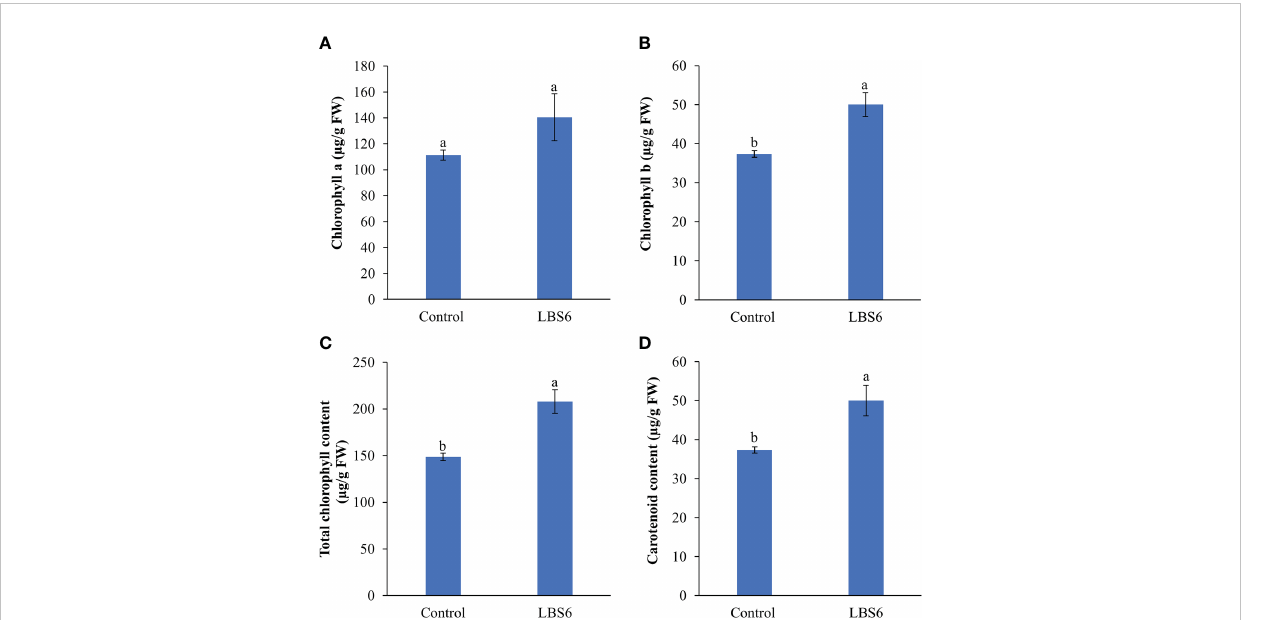
FIGURE 2 LBS6 improved the pigment content of treated cotyledons. (A) chlorophyll a, (B) chlorophyll b, (C) total chlorophyll, and (D) carotenoid content of seven-day old cotyledons treated with water (Control) and LBS6. The values were presented as mean ± SE of three independent replicates, and signi fi cantly different mean values were represented by different